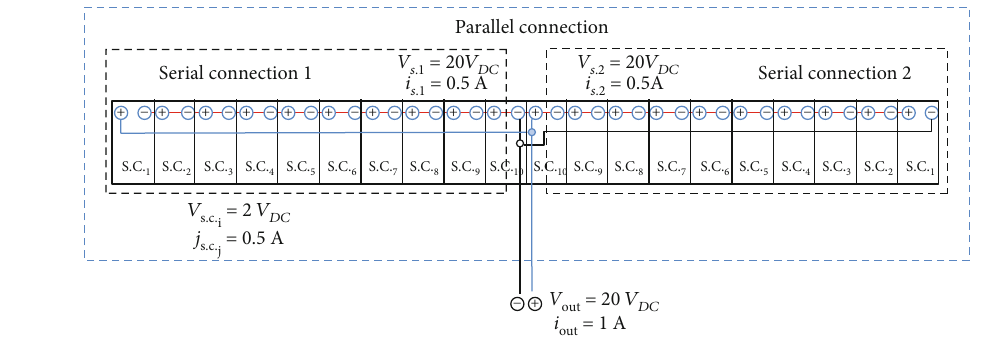
Figure 20: Electrical connections of solar cells.